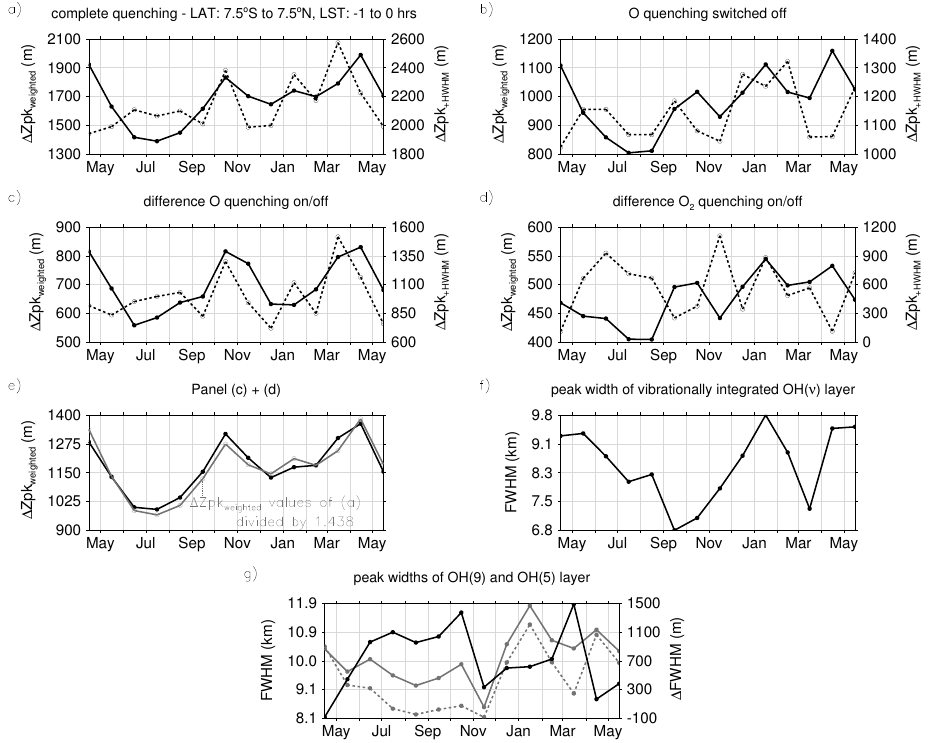
Figure 4. (a–d) Seasonal variability of vertical OH(9;5) profile shifts from April 2010 to June 2011 for different model runs within the equatorial range between ± 7.5 ◦ and the LST range from − 1 to 0h. Solid line/left axis: OH(9;5) vertical shifts between weighted peak altitudes (see definition 3). Dashed line/right axis: OH(9;5) vertical shifts between the +HWHM-shifted peak positions (see definition D.1). (a) Full quenching model run. (b) Deactivated O quenching model run. (c) Difference in OH(9;5) vertical shifts when switching O quenching on/off. (d) Difference in OH(9;5) vertical shifts when switching O 2 quenching on/off. (e) Sum of (c) and (d) (black line). In addition, 1 Zpk weighted from (a) divided by 1.438 shown by grey line. (f) Full peak width of the vibrationally integrated OH( ν ) layer. (g) /left axis: Full peak widths of OH(9) and OH(5) layers (dashed and solid grey lines). (g) /right axis: Relative difference between the full peak widths of the OH(9) and OH(5) layers (black solid line).